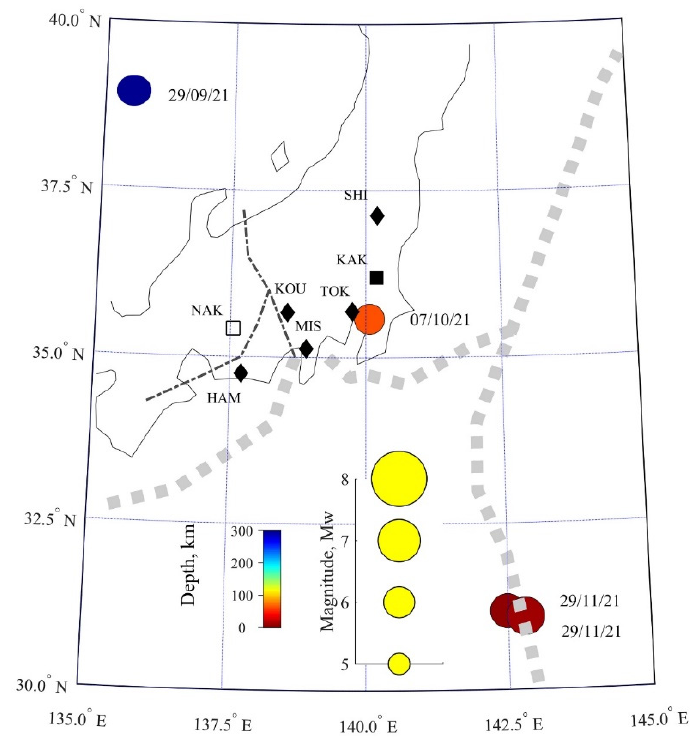
Figure 1. Map illustrating the positions of magnetic observatories (black box of Kakioka (KAK) and white box (Nakatsugawa, NAK)), together with weather stations of SHI, TOK, MIS, KOU, and HAM (in rhombus). A red circle is the epicenter of our EQ, together with EQs with M > 5.8, which occurred from 1 August to 31 November 2021.